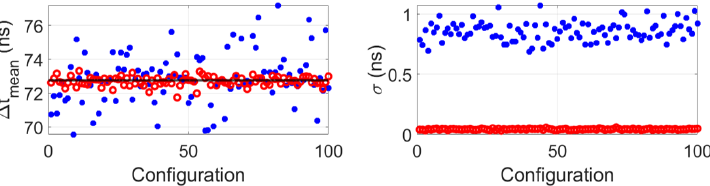
Figure 12. Simulation results of mean ( left ) and standard deviation ( right ) of the transit time difference for 100 random configuration for the case of 10 inactive array elements situated at random locations along the aperture of 96 − elements arrays and considering a flow speed of v f = 0.5m/s. Blue dots represent the values obtained without implementing the proposed algorithm (i.e., after just beam-forming, obtaining and averaged signal per array and cross-correlating them to obtain the transit time difference), and the red circles represent the values obtained after implementing the proposed algorithm. The horizontal black line represents the value obtained without inactive elements, i.e., ∆ t mean =